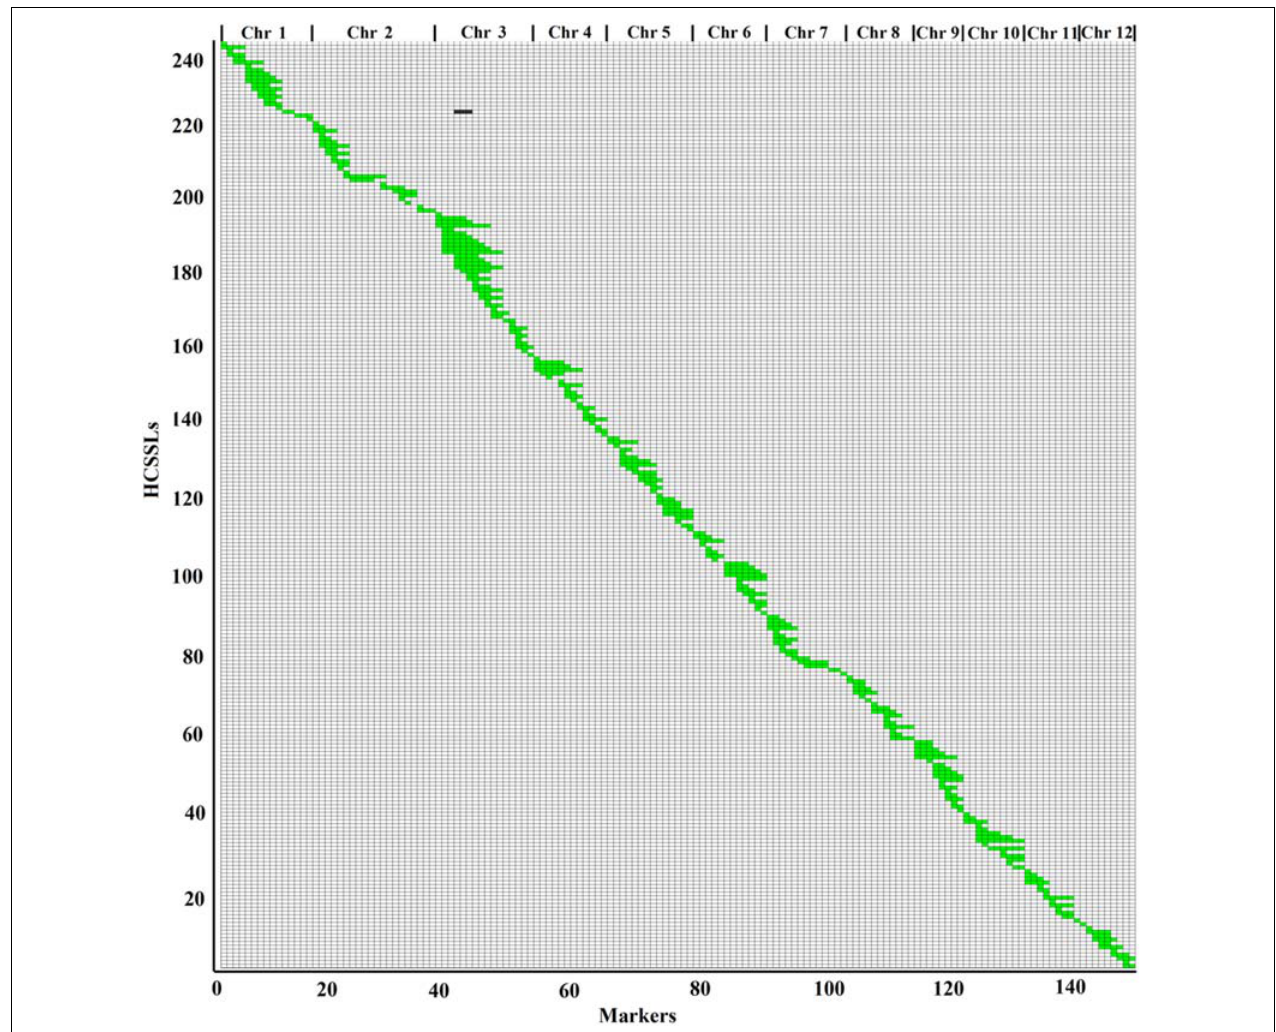
FIGURE 4 | Physical map of the 244 HCSSLs. Each row represented a HCSSL and each column represented a molecular marker locus. The black areas indicate regions that were homozygous genotypes for ZhangPu Wild Rice alleles; the white areas indicate regions homozygous for Dongnanihui 810 alleles; the green areas indicate regions that were heterozygous genotypes for Dongnanihui 810 and ZhangPu Wild Rice.